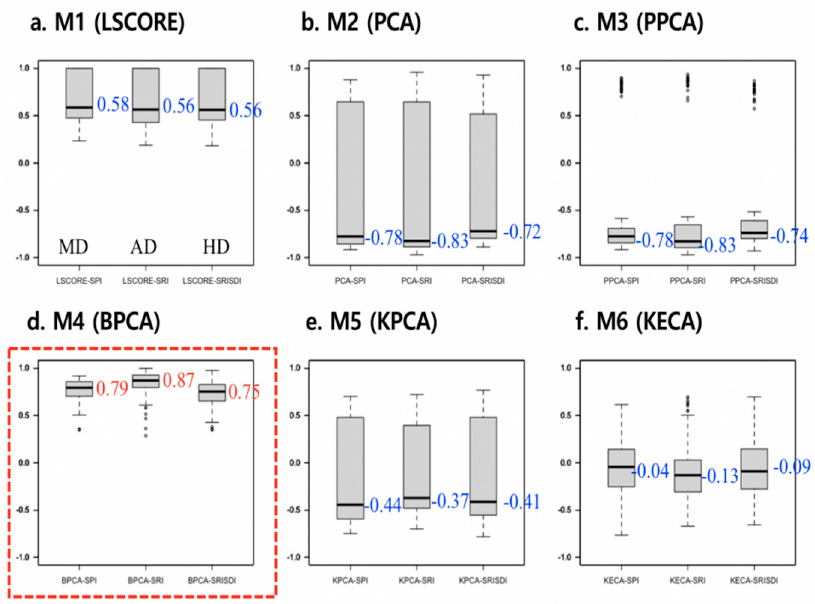
Figure 4. Accuracy distribution of the ground data-based drought index.